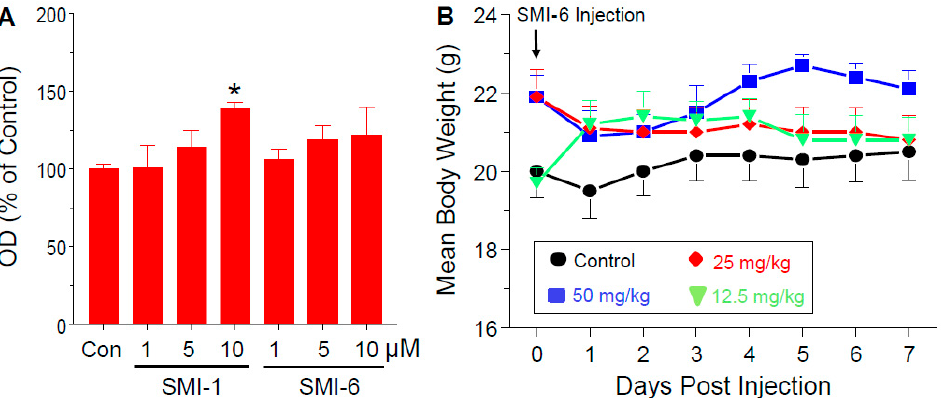
Figure 6. Lack of in vitro cytotoxicity or acute in vivo toxicity by SMI-6. ( A ) Lactic dehydrogenase release in response to incubating MDA-MB-468 cells with various doses of SMI-1 or SMI-6 for 24 h. Values are means ± SEM of 3 determinations. * significant ( p < 0.05) vs. control. ( B ) SMI-6 had no effects on body weight in female mice given single ip injections of vehicle control or various doses SMI-6 and observed for 7 days. (means ± SEM; n = 5 mice).